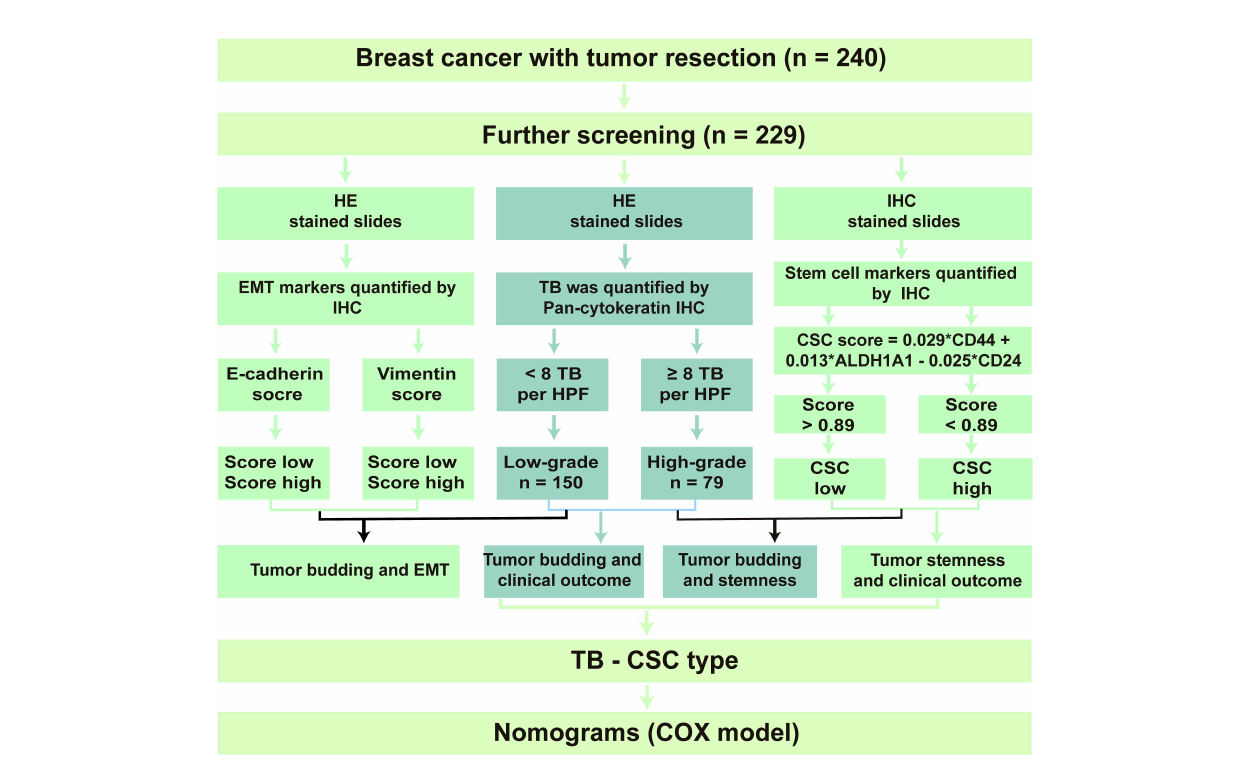
FIGURE 1 | Flow chart of the study